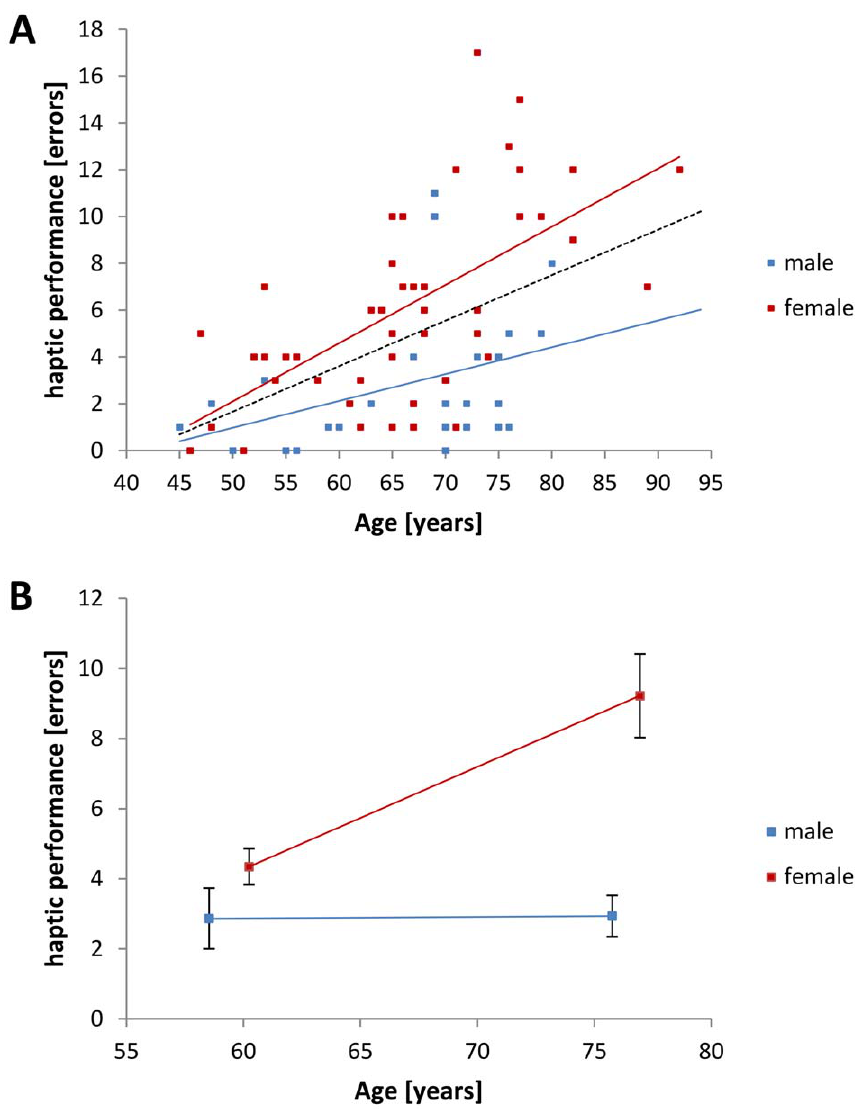
Figure 1. Development of haptic performance in later life. A. Individual haptic performance (i.e., number of errors) is depicted for male (blue squares, N=31) and female (red squares, N=47) subjects. Trend lines are inserted for male (solid blue), female (solid red), and all subjects (dashed black). Haptic performance declined with increasing age (Pearson correlation, N=78, r=0.479, p # 0.001). B. Group data for haptic performance (i.e., number of errors) for younger adults (left squares; females: N=29, 60.24 6 7.07 years; males: N=15, 58.53 6 7.62 years) and older adults (right squares; females: N=20, 76.95 6 5.94 years; males: N=17, 75.76 6 6.71 years). There was a significant interaction of the subjects’ age and gender with their haptic performance (AGE*GENDER: F (1,31) =17.535; p # 0.001). Black bars indicate SEM.